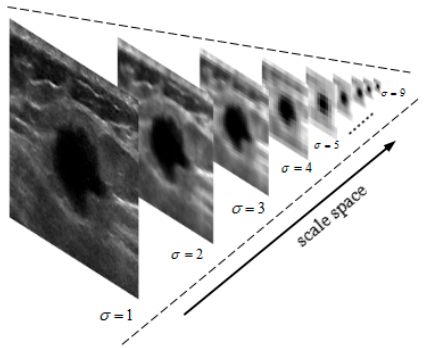
Figure 2. Gaussian pyramid of an input image.